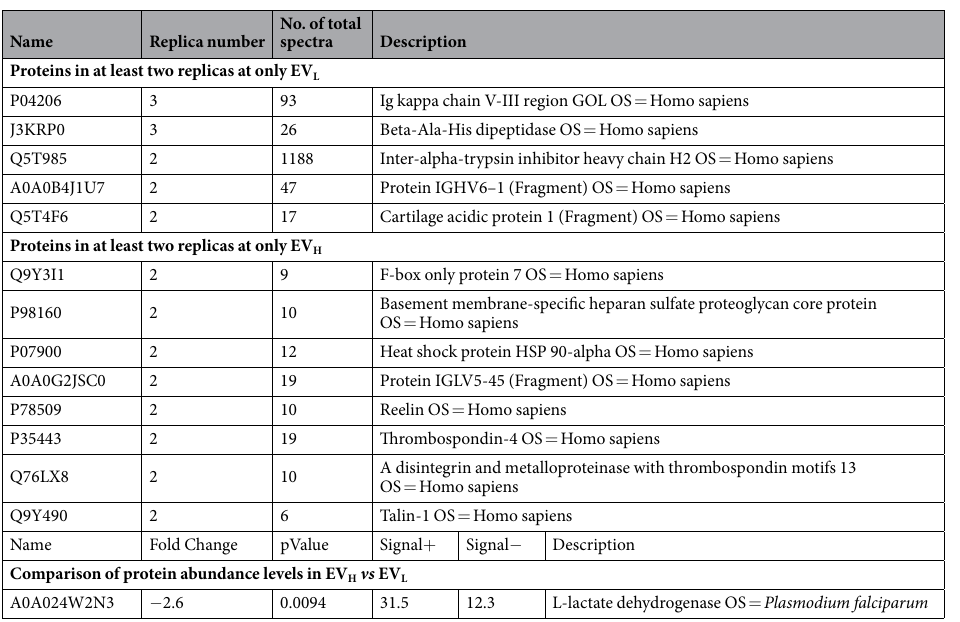
Table 1. Differential proteomic analysis of EV L and EV H by nanoLC MALDI TOF